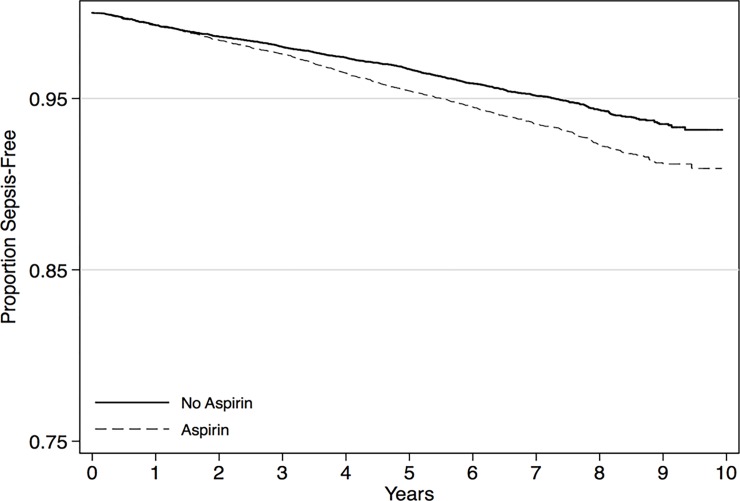
Kaplan Meier curve for first sepsis events, stratified by baseline aspirin use.